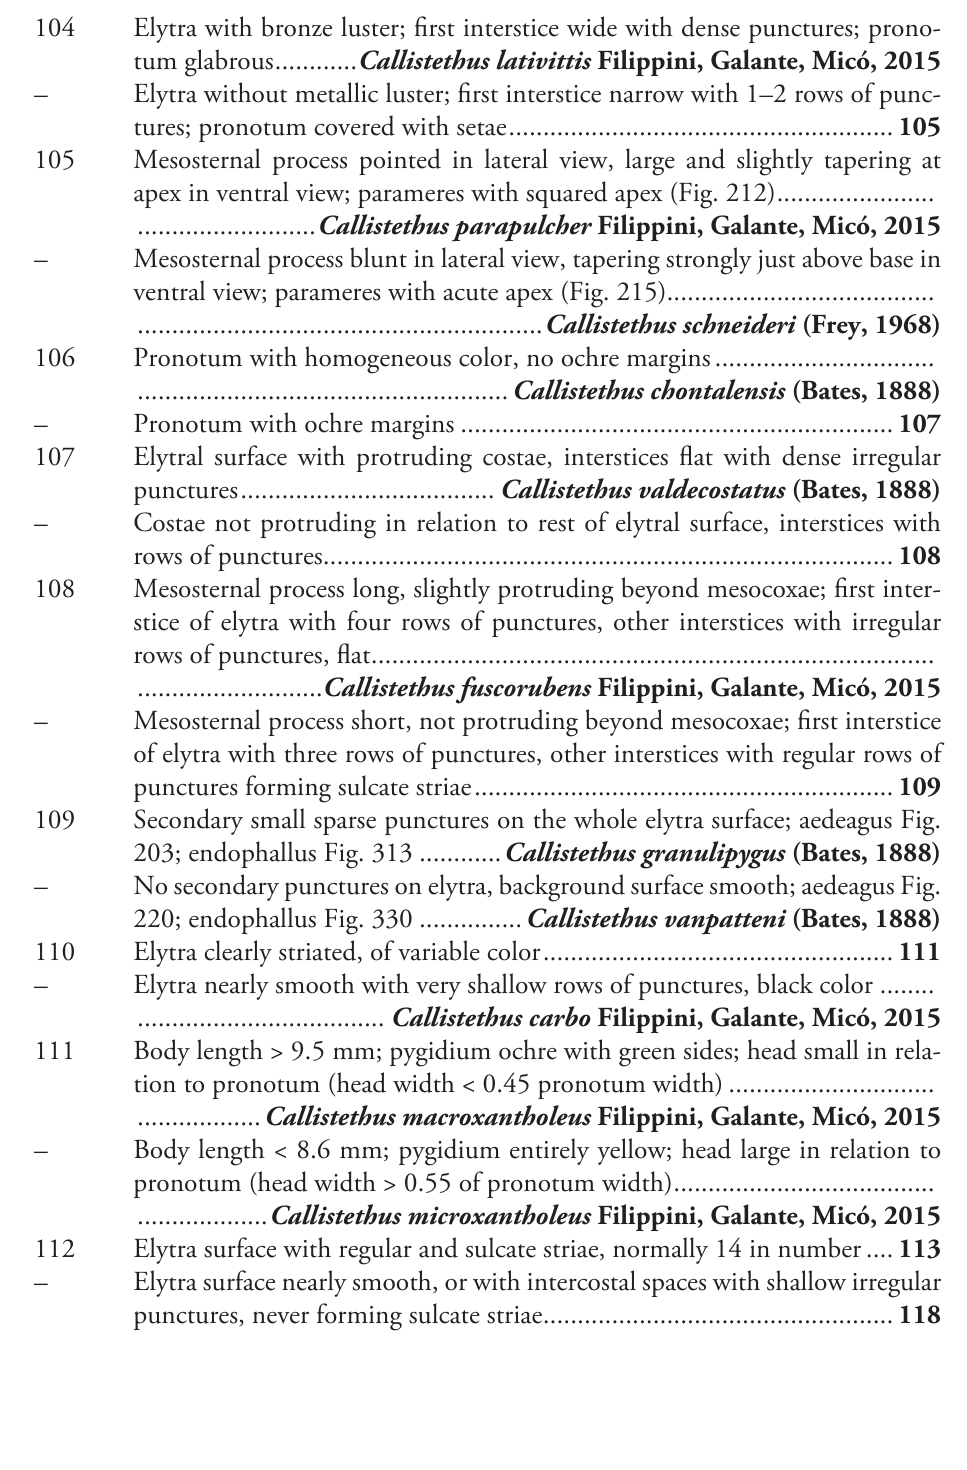
Elytra with bronze luster; first interstice wide with dense punctures; prono- – Elytra without metallic luster; first interstice narrow with 1–2 rows of punc- 105 Mesosternal process pointed in lateral view, large and slightly tapering at apex in ventral view; parameres with squared apex (Fig. 212) ....................... – Mesosternal process blunt in lateral view, tapering strongly just above base in